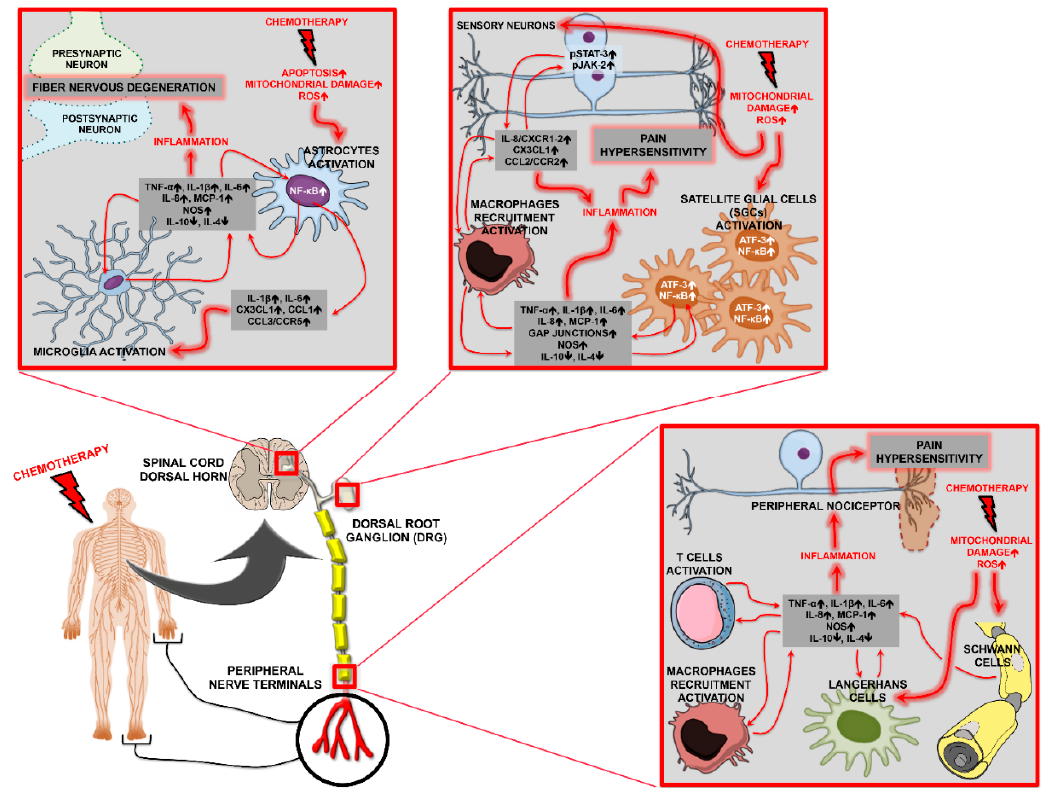
Figure 1. Summary scheme indicating the di ff erent players driving chemotherapy-induced peripheral neuropathy (CIPN).